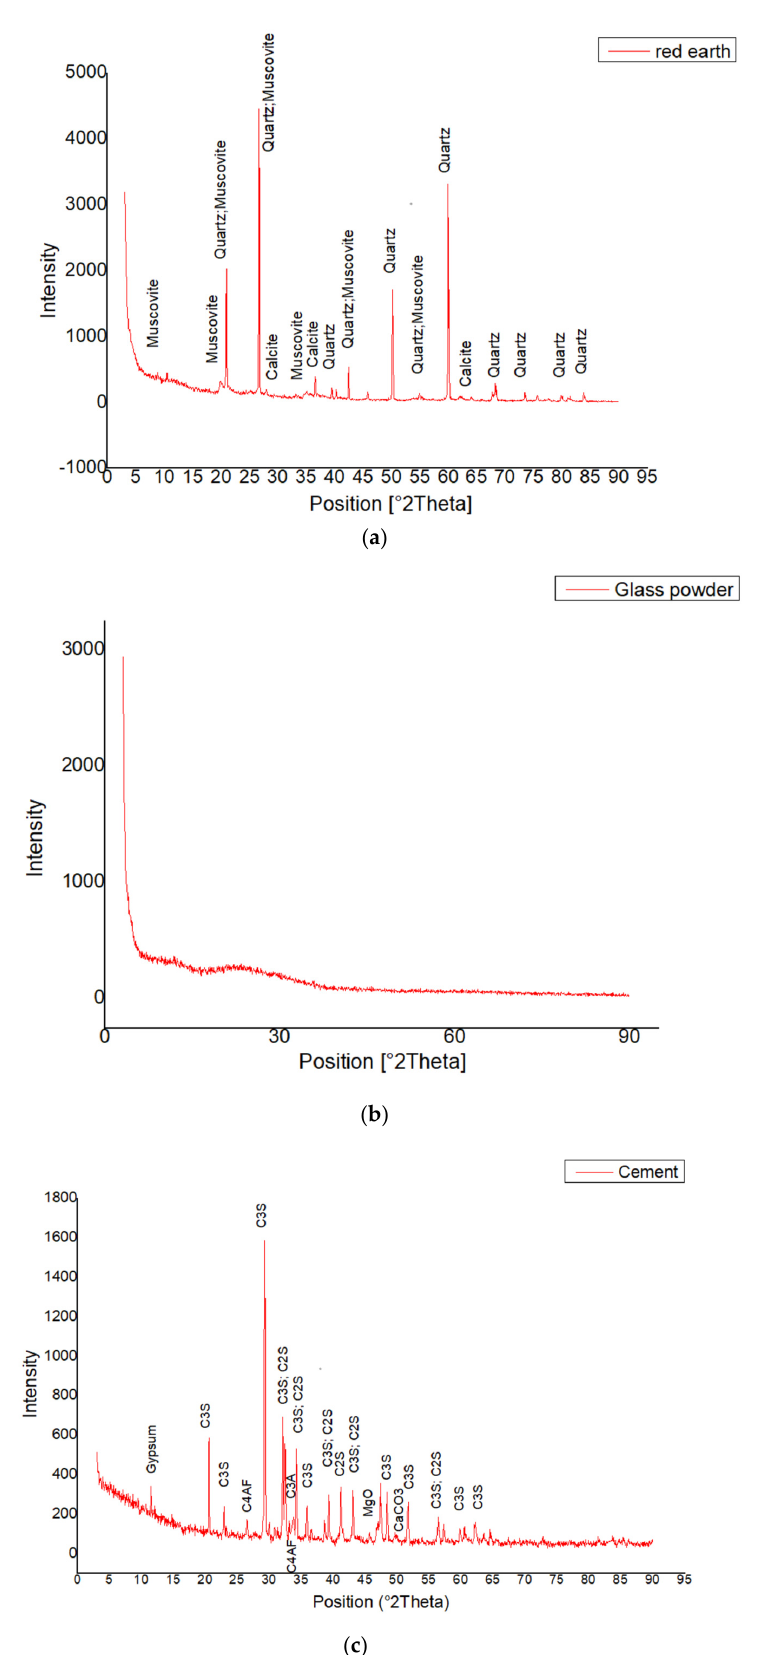
Figure 2. X ‐ ray diffraction patterns of ( a ) red earth powder, ( b ) glass powder, and ( c ) cement.